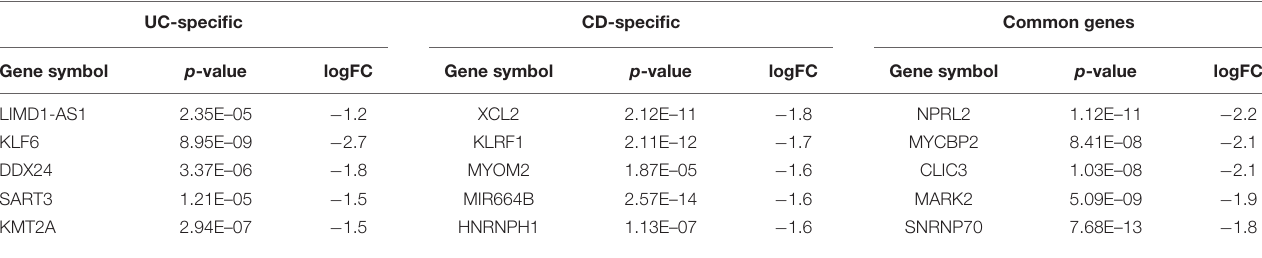
TABLE 3 | Top five downregulated DEGs and their corresponding p -values and logFC values of the UC-specific, CD-specific, and common genes.